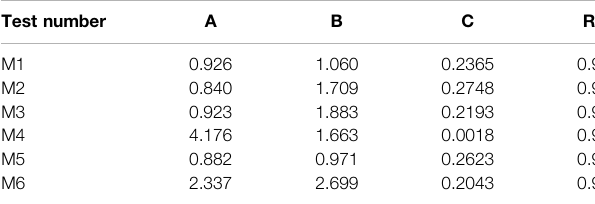
TABLE 4| Fitting results ofthe relationship between theliquefaction cyclenumber ratio and reconsolidation degrees of